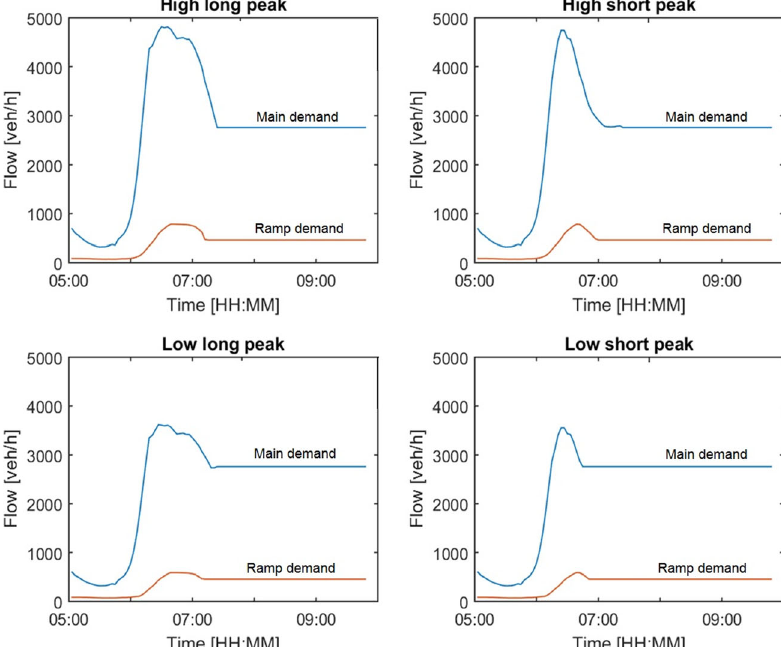
Fig. 1 Main demand peak profiles (some intermediate cases are also